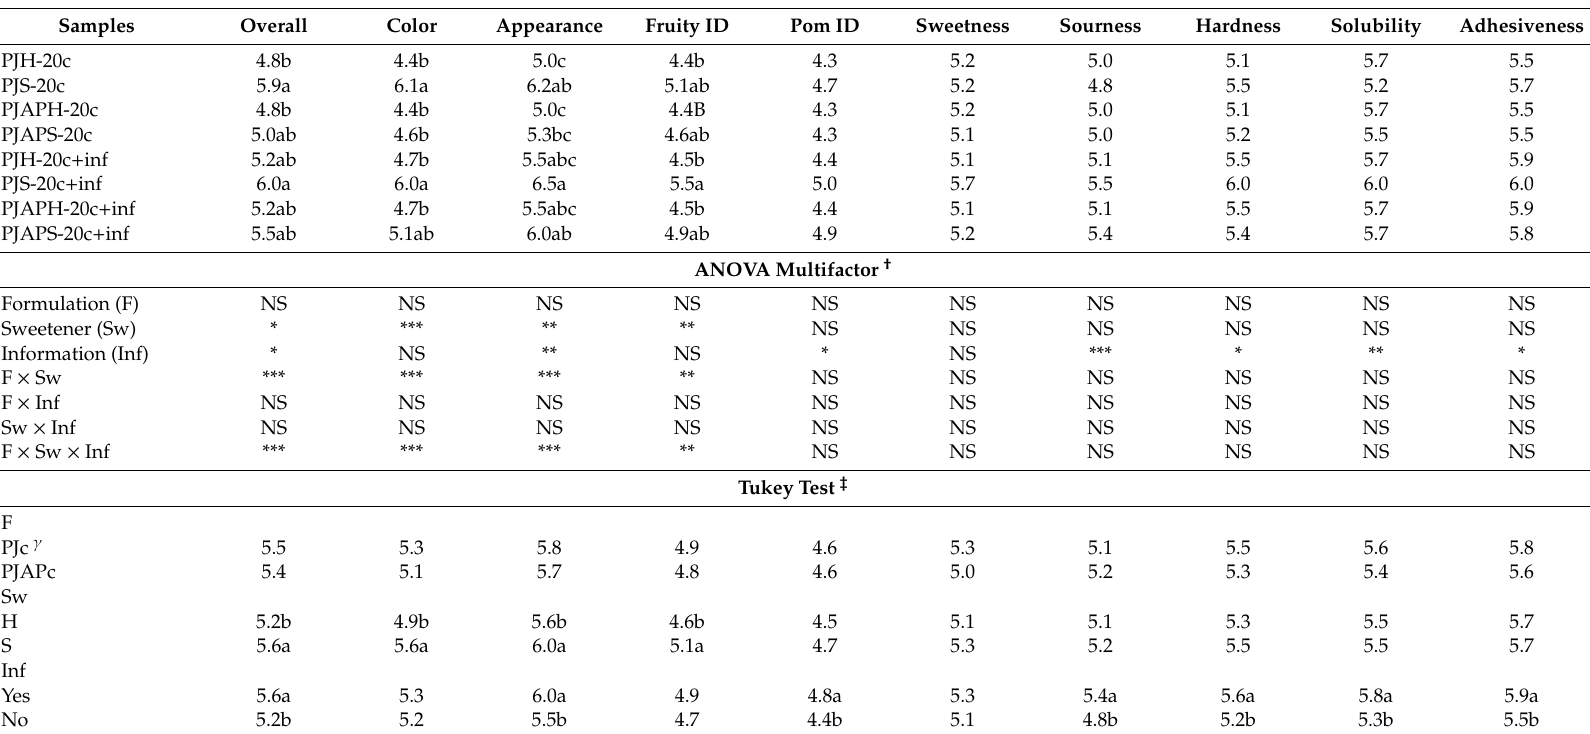
Table 5. Mean scores and ANOVA for color, appearance, flavor notes, basic taste, texture, and overall liking for